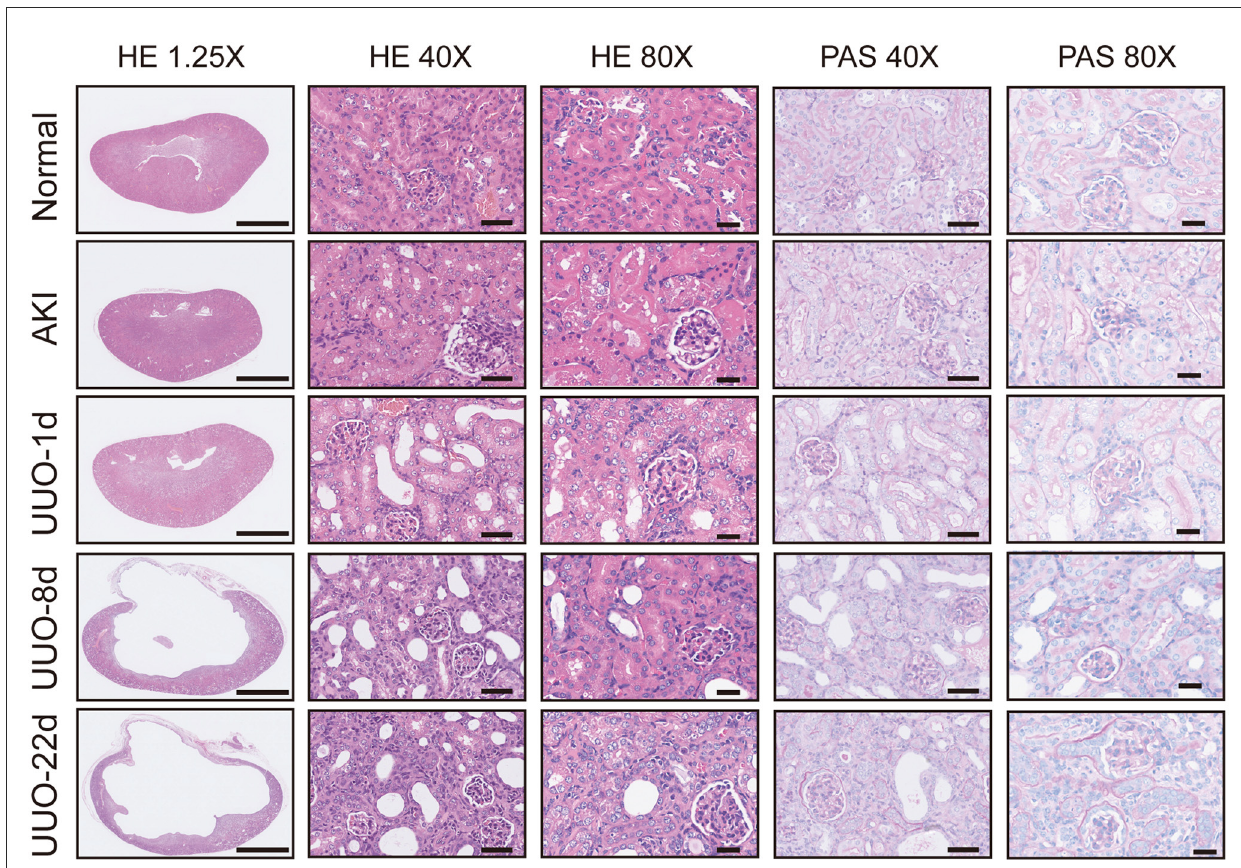
FIGURE5 Pathological sections of healthy kidneys and kidneys with renal dysfunction. Scale bar for 1.25 × : 2.5mm, 40 × : 50 µ m, 80 × : 25 µ m.